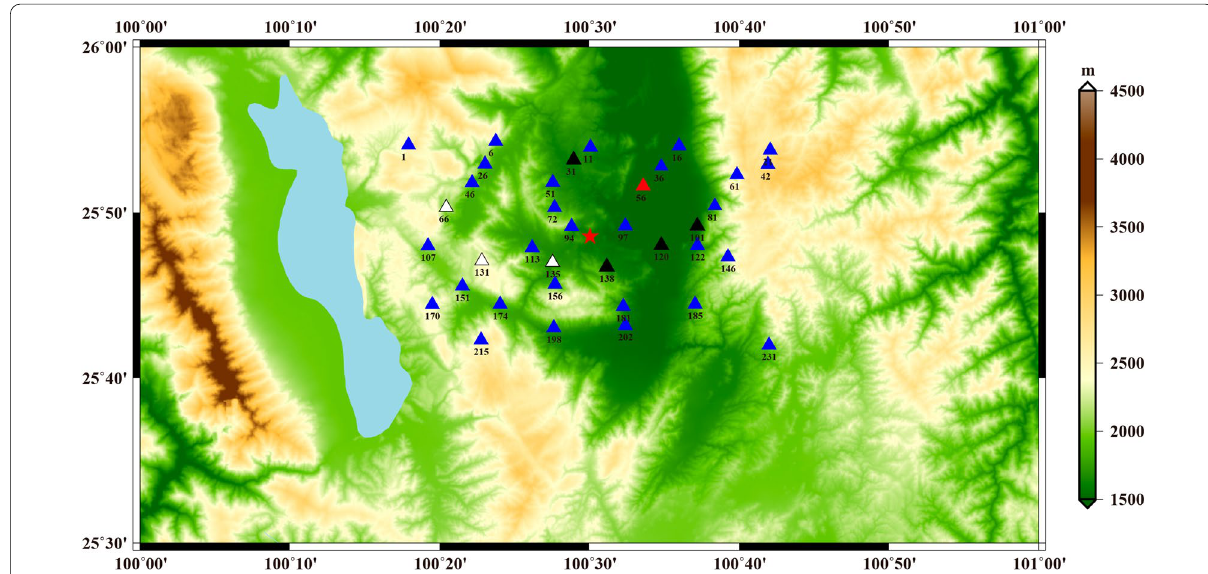
Fig. 14 Distribution of anomalous stations. The red triangle is the anomalous station in both methods, the white triangles are the anomalous stations unique to the amplitude–distance attenuation method, the black triangles are the anomalous stations unique to the coda normalization method